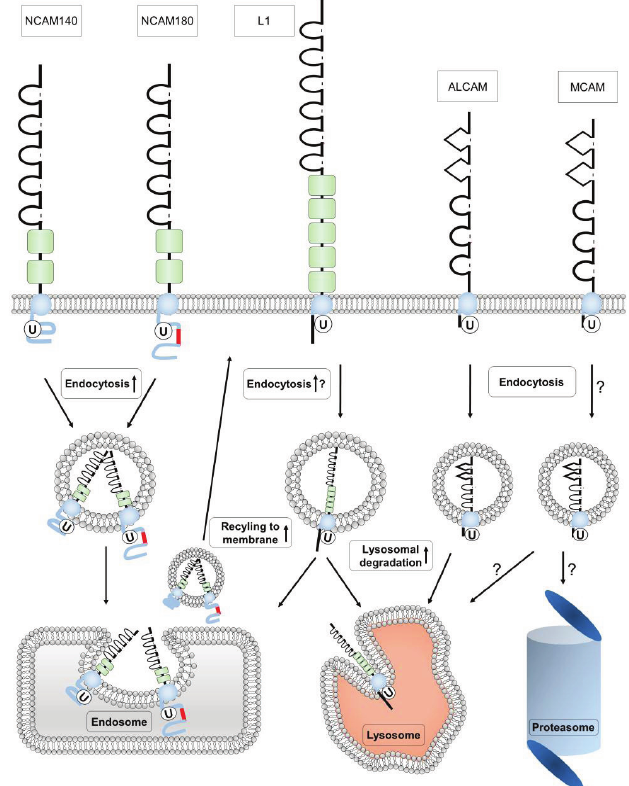
Figure 3. Overview about the function of ubiquitination for different Ig superfamily cell adhesion molecules. All depicted molecules are internalized after a specific stimulus. Ubiquitination (U) of NCAM increases its endocytosis ( ↑ ) but has no effect on its lysosomal degradation after overexpression of ubiquitin. However, cleavage of ubiquitin by the de-ubiquitinating enzyme UCHL1 results in decreased lysosomal degradation of NCAM thus favoring its recycling to the cell surface ( ↑ ). For L1 it could be shown that ubiquitination increases its lysosomal degradation ( ↑ ) whereas it is not yet clear whether it also upregulates its internalization ( Ò ?). ALCAM’s endocytosis does not seem to be regulated by its ubiquitination although ubiquitin overexpression decreases ALCAM expression. This is most likely attributable to increased lysosomal degradation ( Ò ). MCAM ubiquitination is mediated by the E3 ligases Smurf1 and β TrCP by a tight crosstalk with ALCAM-mediated signal transduction and leads to MCAM downregulation. The detailed mechanism of its degradation has not yet been investigated